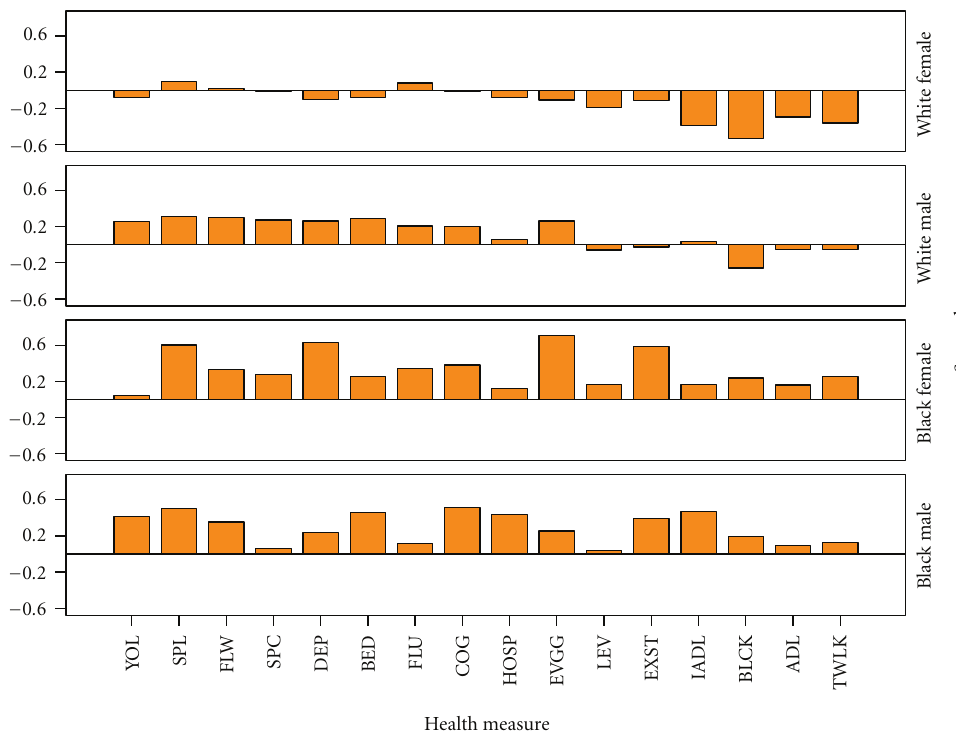
Figure 1: Adjusted di ff erence in YHL (Overweight BMI − Normal BMI).